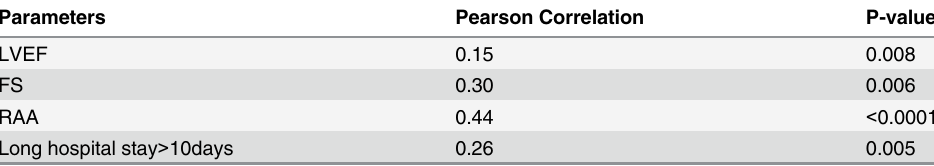
Table 4. Independent Co-variants of Right Ventricular Systolic Dysfunction using